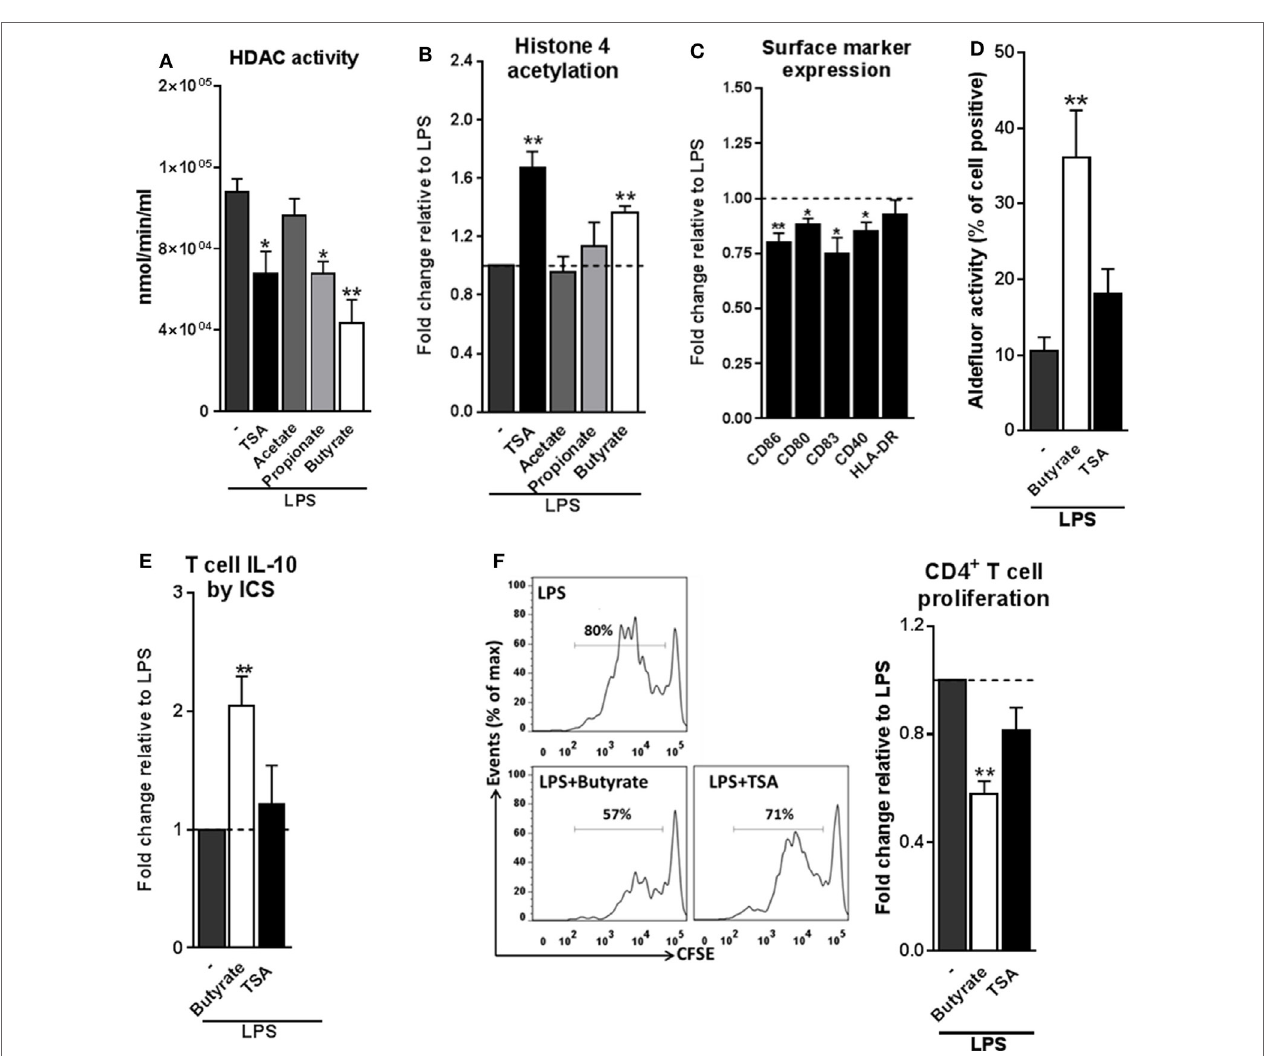
FigUre 4 | Histone deacetylases (HDAC) inhibition by butyrate is not sufficient for inducing type 1 regulatory T cells-promoting human tolDCs. (a) Dendritic cells (DCs) were stimulated for 24 h with indicated reagents and then assayed for HDAC activity. (B) Analysis of histone 4 acetylation by flow cytometry of DCs stimulated with indicated reagents for 6 h. (c) The expression of maturation markers of DCs stimulated for 48 h with TSA was analyzed using flow cytometry. The expression of surface marker levels is based on the geometric mean fluorescence. (D) Retinaldehyde dehydrogenase activity assay as described in Figure 3D . (e) IL-10 production by T cells as described in Figure 2B . (F) T-cell suppression assay as described in Figure 2D . (a–F) Bar graphs represent means ± SEM of at least three experiments and (B,c,e,F) are shown as fold change relative to control conditions. *p < 0.05, ** p < 0.01, *** p < 0.001 based on paired Student’s t